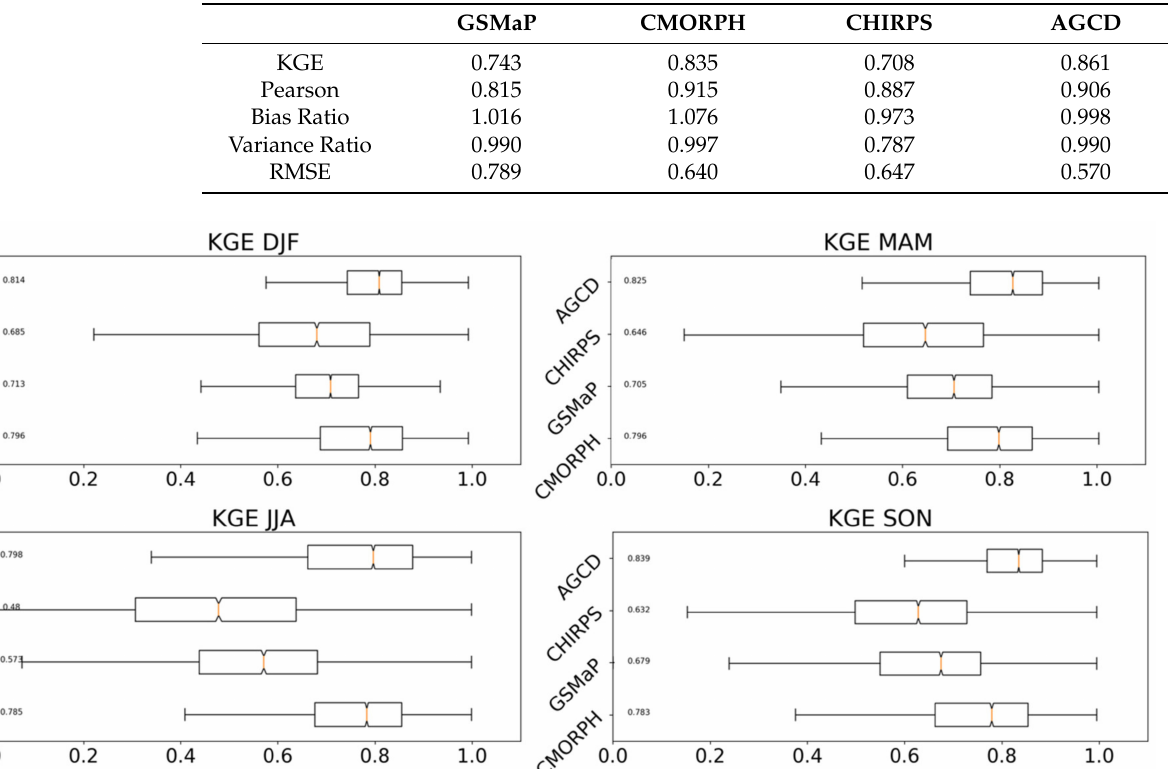
Table 3. Medians for the values at each pixel across the study area.